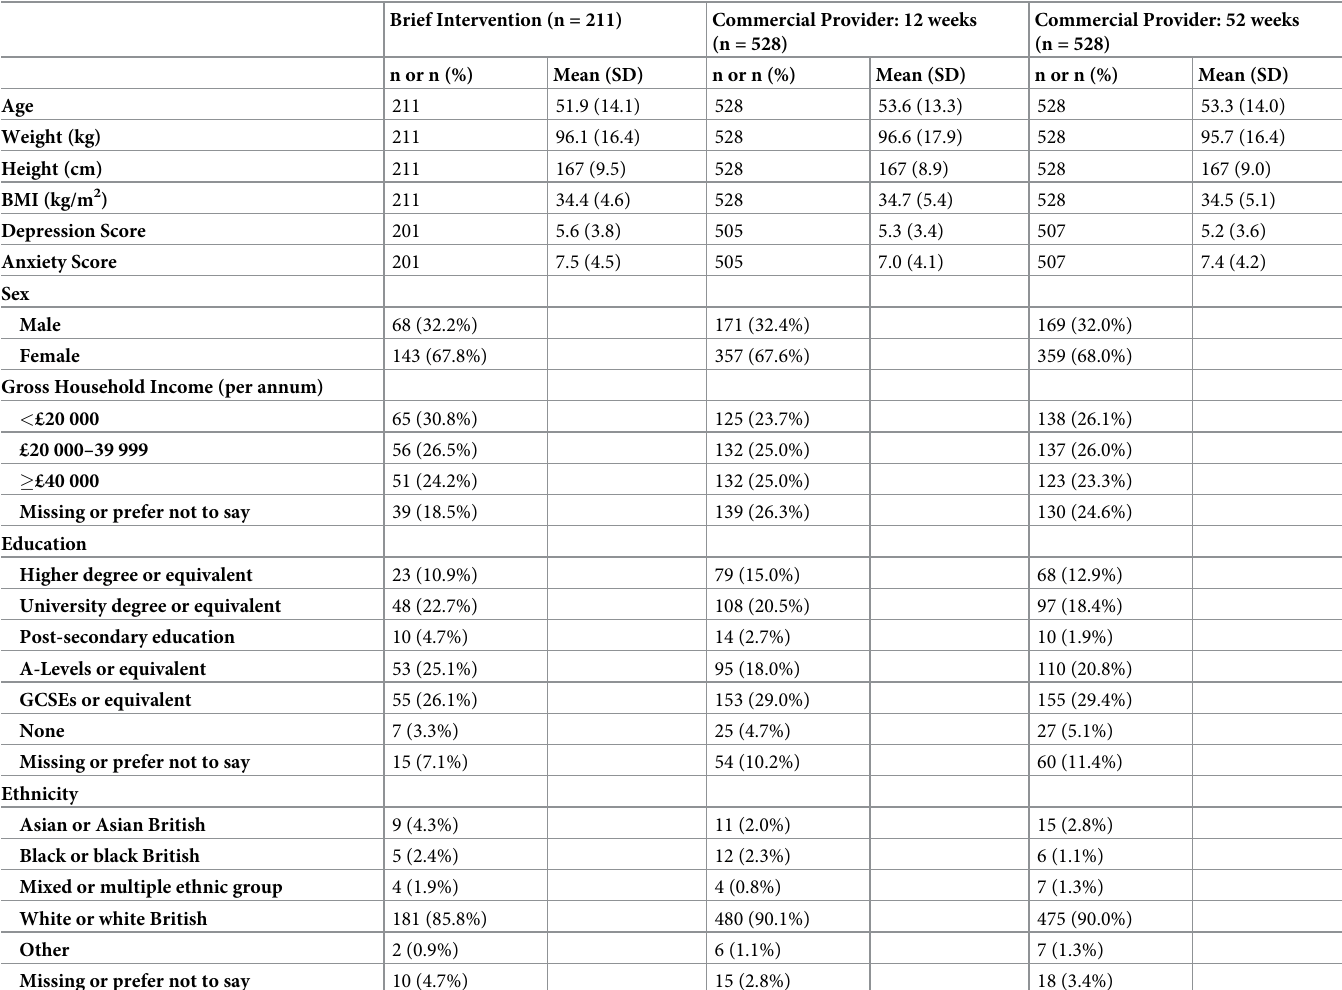
Table 1. Baseline characteristics of 1267 participants allocated to brief intervention or to commercial provider for 12 or 52